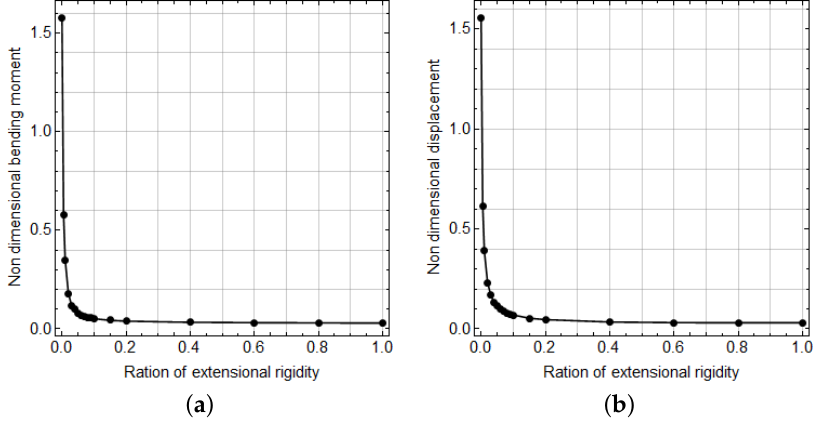
Figure 18. Effect of the ratio of extensional rigidity α in Case 3-4 with vertical and horizontal reinforcing member: ( a ) nondimensional stress; ( b ) nondimensional displacement.